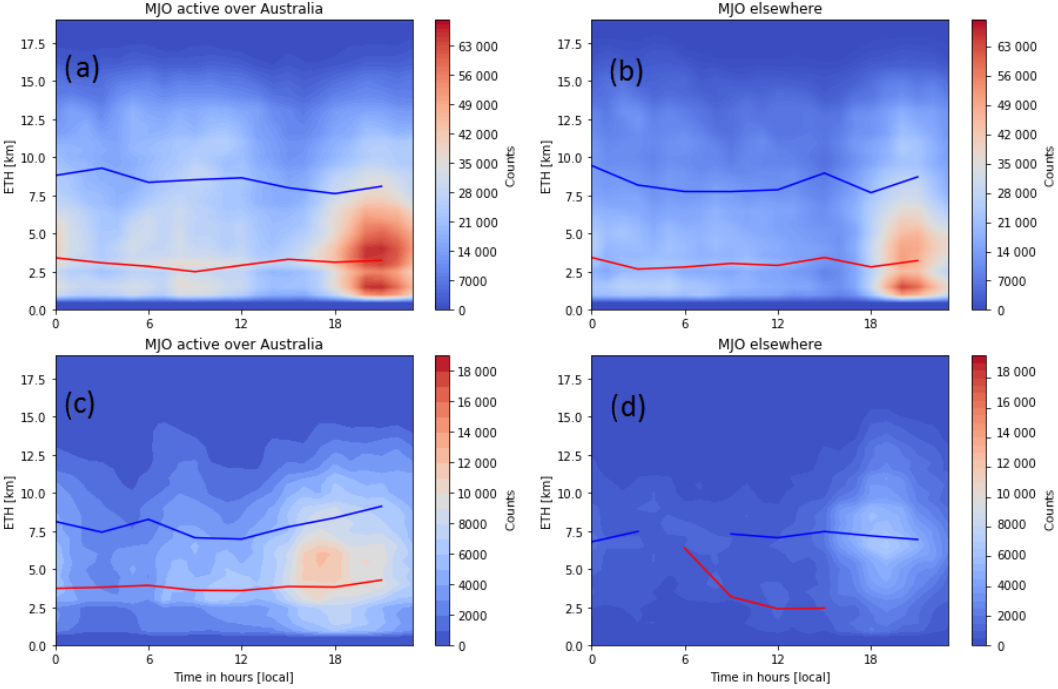
Figure 12. (a) frequency distribution of occurrence of ETHs in convective regions as a function of time in break conditions when the MJO is active over Australia. Red line indicates peak of cumulus congestus mode, and blue line indicates peak of deep mode of convection. (b) as in (a) , but for when the MJO is inactive over Australia. (c, d) as in (a, b) , but during active monsoon